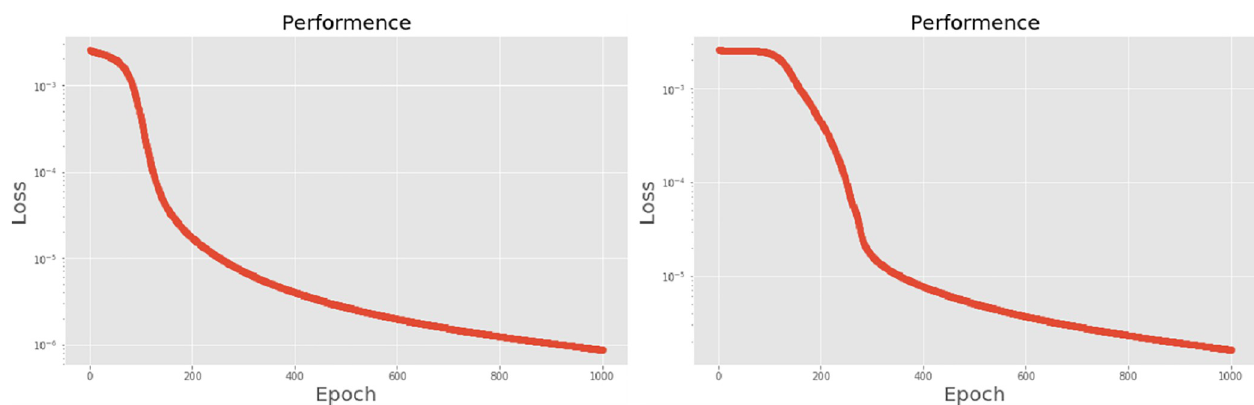
Fig 28. (a) The graph shows the performance of MFCC-LSTM-2 × 700 model; (b) The graph shows the performance of MFCC-PCA-LSTM-2 × 700 model.